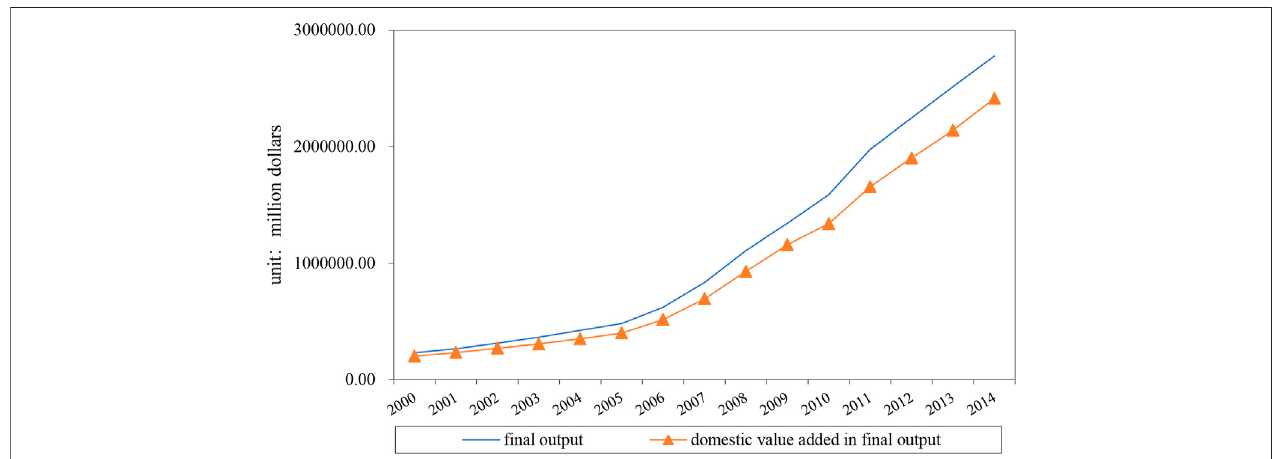
FIGURE 1 | The fi nal output and domestic value-added in the fi nal output of China ’ s construction industry during 2000 – 2014.